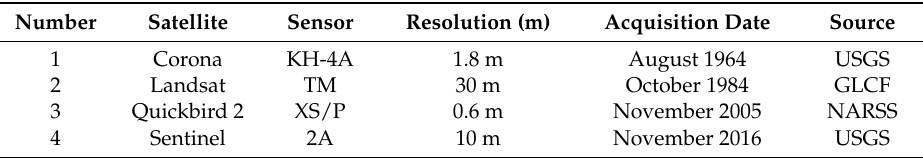
Table 1. Main satellite images properties.